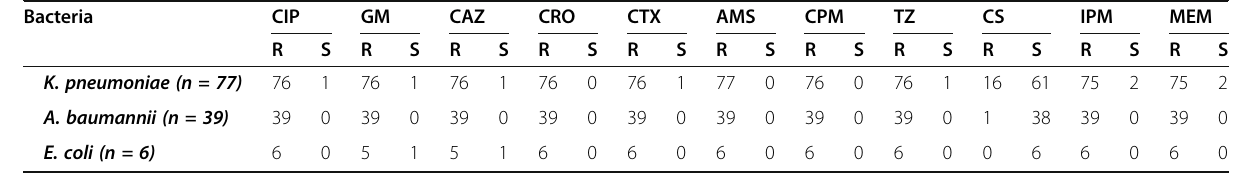
Table 1 Antimicrobial susceptibility testing for 122 nonduplicated isolates of Klebsiella pneumoniae , Acinetobacter baumannii , and Escherichia coli strains isolated over study